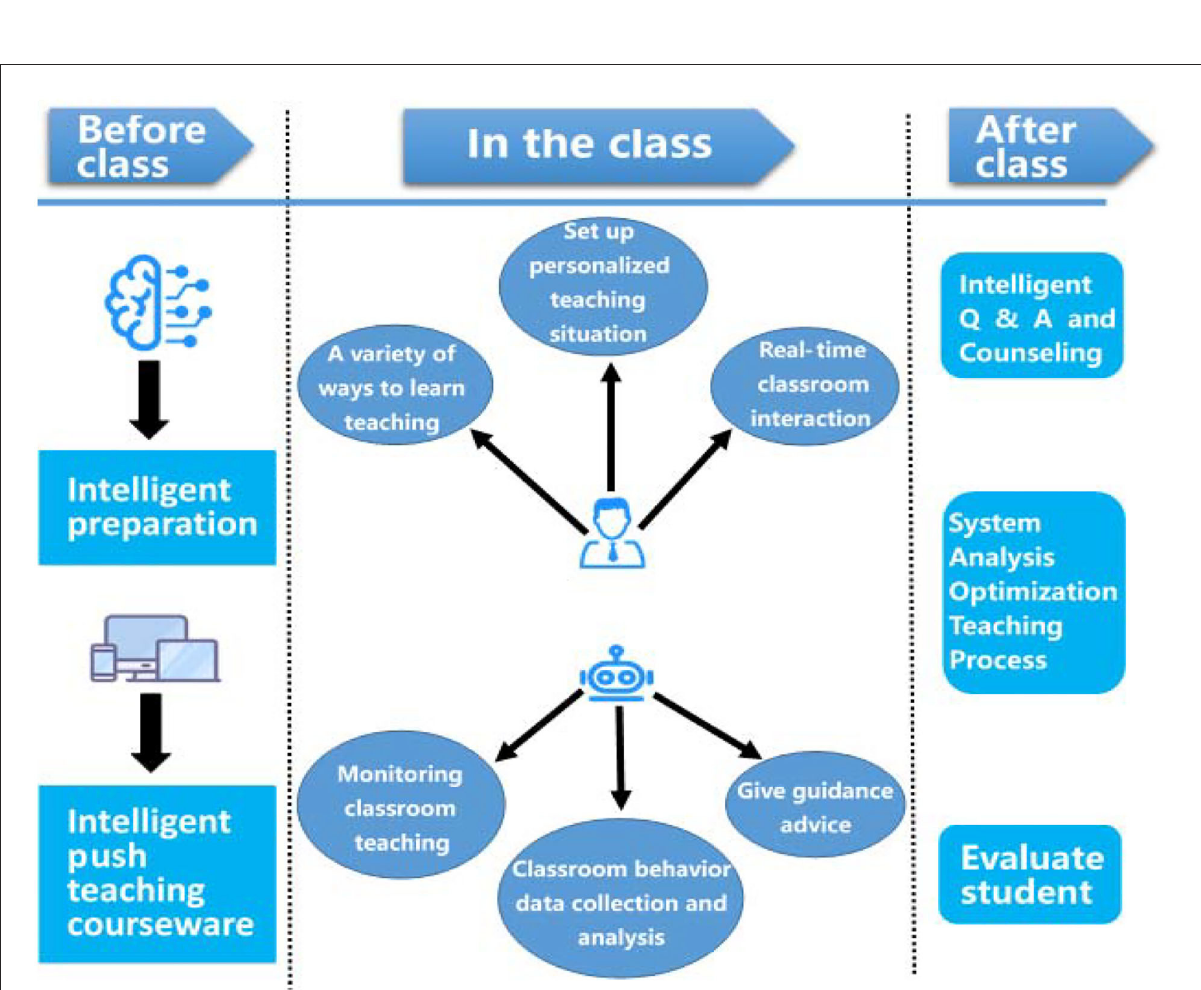
FIGURE2 Research process of the proposed intelligent teaching